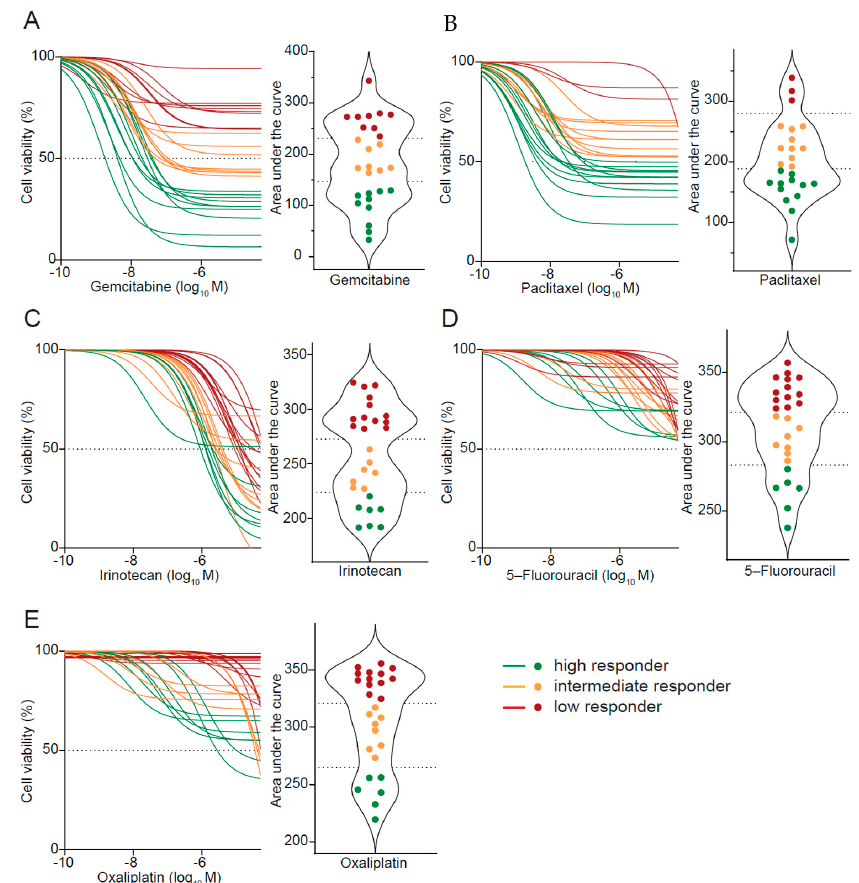
Figure 2. Patient-derived organoids exhibit heterogeneous responses to standard-of-care agents. ( A – E ) Cell viability analyses (left panels) and violin plots (right panels) depict corresponding areas under curves of gemcitabine ( A ), paclitaxel ( B ), irinotecan ( C ), 5-fluorouracil ( D ), and oxaliplatin ( E ) treatment in patient-derived organoids (PDOs). Dotted lines (right panels) represent cut-off values as determined by the Jenks Natural Breaks classification method. PDOs were classified into three subgroups: high responder (green), intermediate responder (orange), and low responder